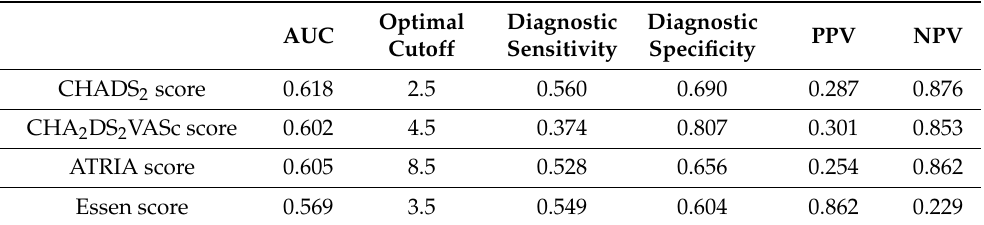
Table 3. Receiver operating characteristic (ROC) curve analysis of risk scores for the probability of an unsuccessful